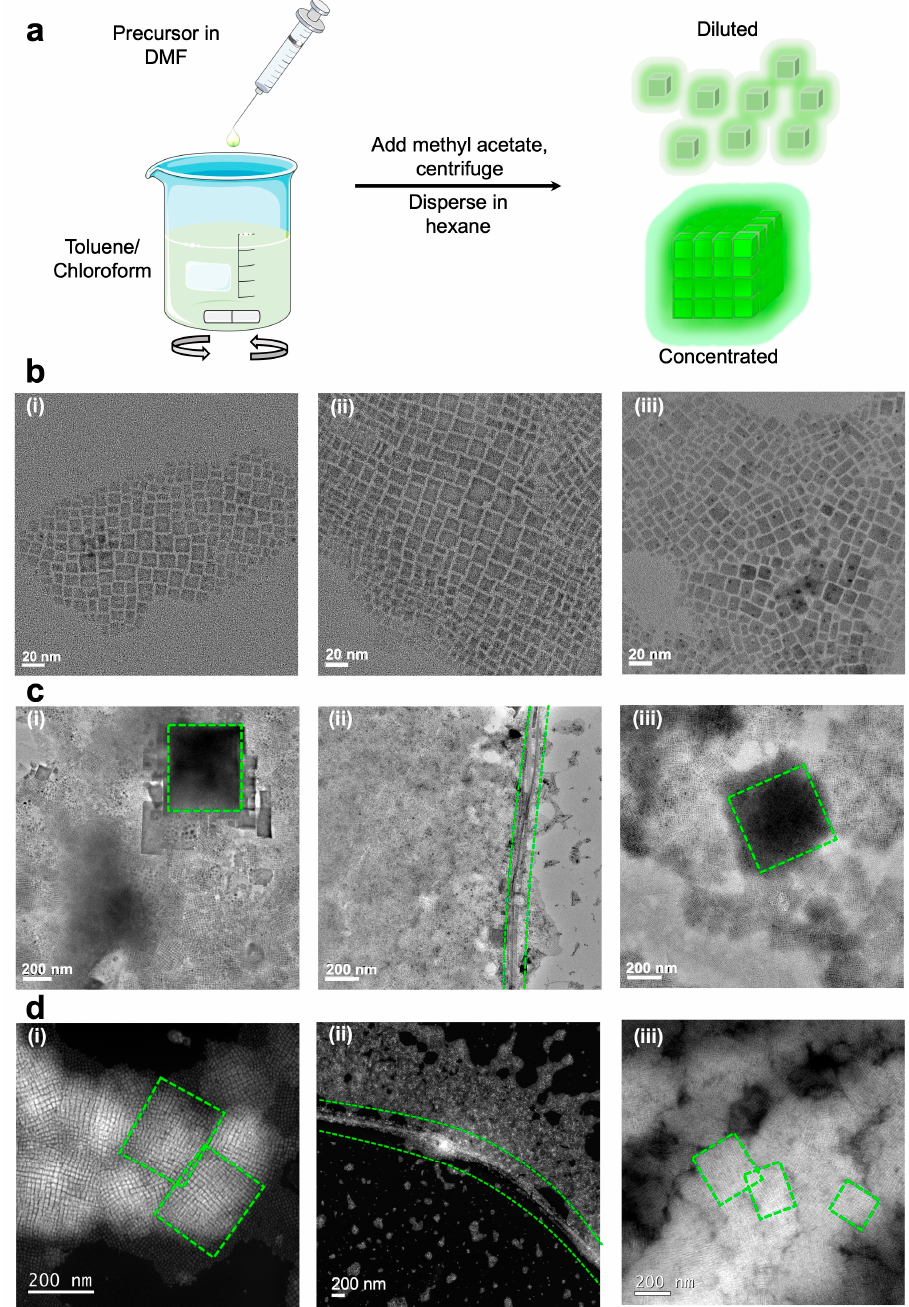
Figure 1. ( a ) Schematic illustration of the LARP synthesis process. ( b ) TEM images of ( i ) MAPbBr 3 , ( ii ) FAPbBr 3 , and ( iii ) CsPbBr 3 NCs. ( c ) TEM images of ( i ) MAPbBr 3 , ( ii ) FAPbBr 3 , and ( iii ) CsPbBr 3 SSs. ( d ) DF-STEM images of ( i ) MAPbBr 3 , ( ii ) FAPbBr 3 , and ( iii ) CsPbBr 3 SSs, with the location of SSs highlighted within the green lines/boxes.